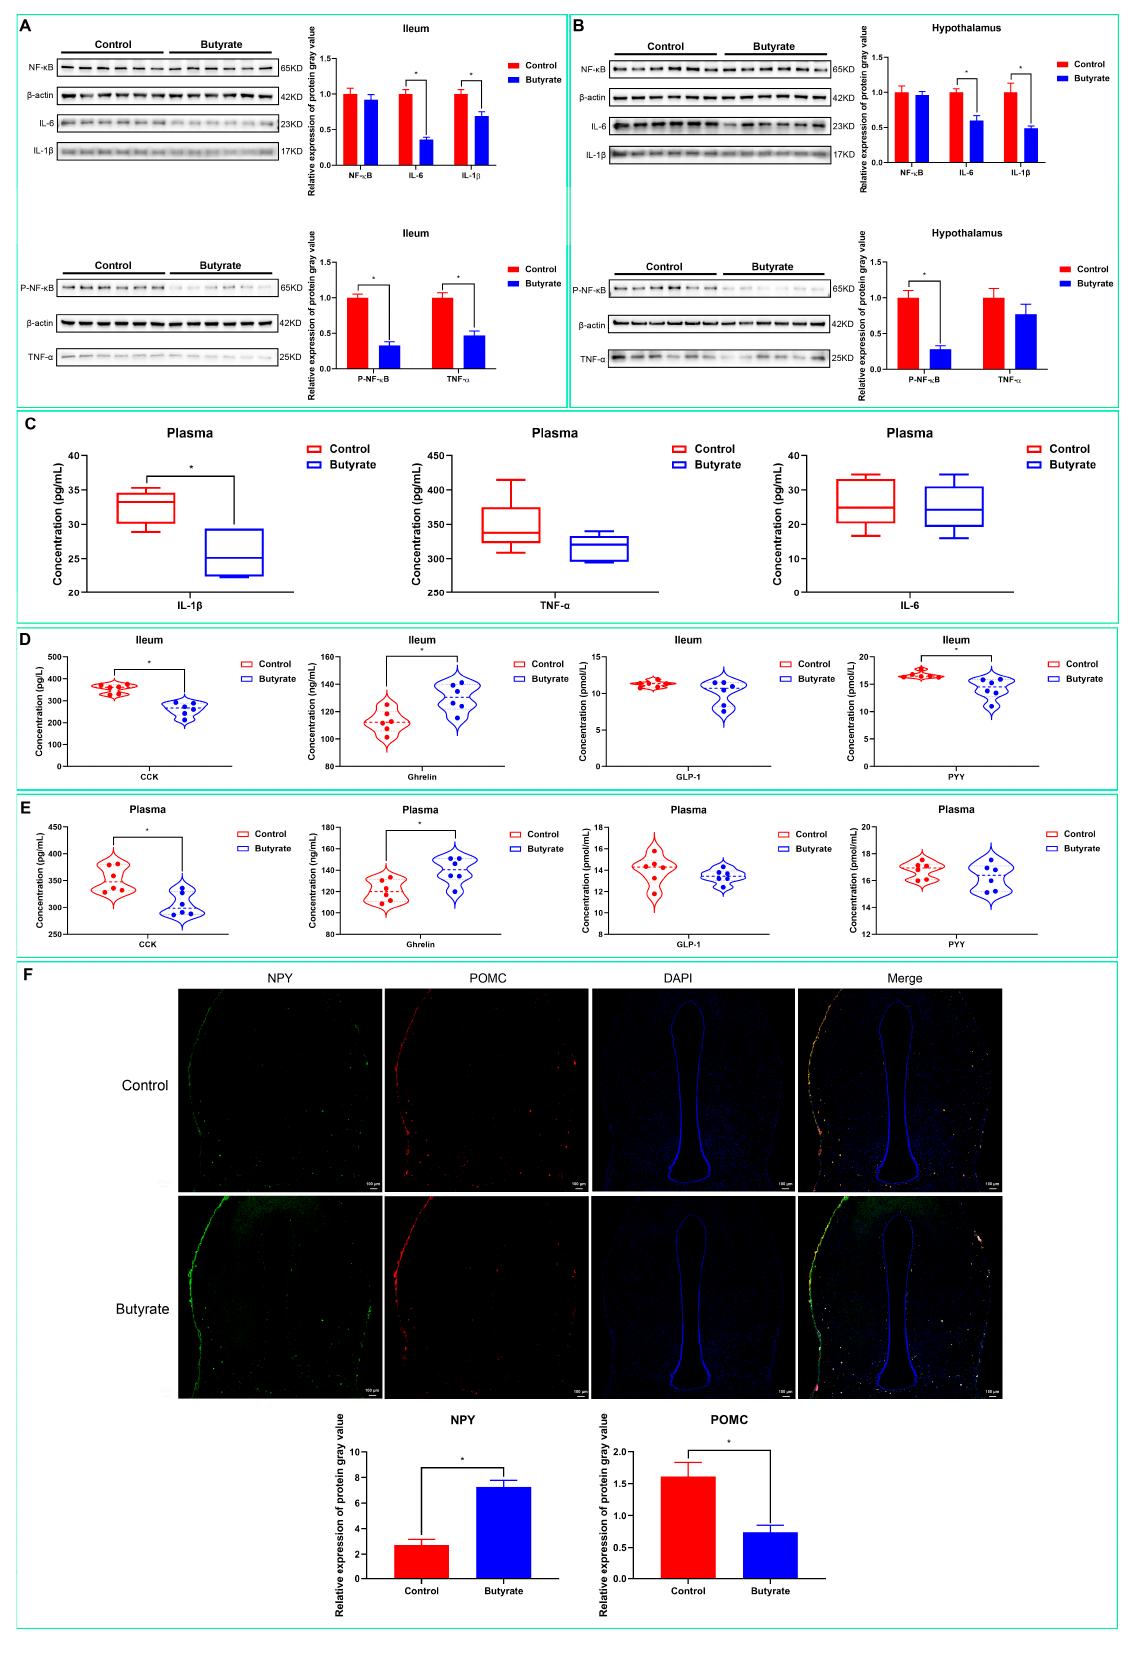
Figure 2. Effect of butyrate on the expression of inflammatory factors and appetite proteins in the ileum, plasma and hypothalamus of weanling rabbits. ( A ) Expression of inflammatory factors in